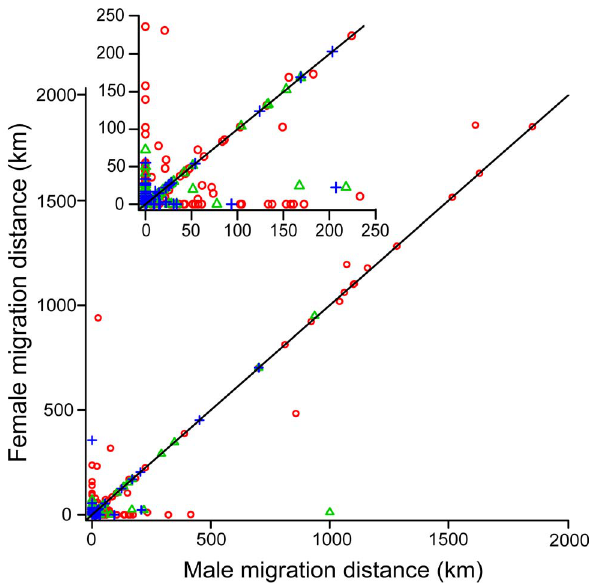
Figure 3. Plot of migration distances for marital pairs. G2 (red circle), G3 M (green triangle), G3 P (blue cross). The solid line shows a theoretical 1:1 relationship, where females and males have the same dispersal distance. The inner box shows a close-up of the relationship for distances less than 250 km.